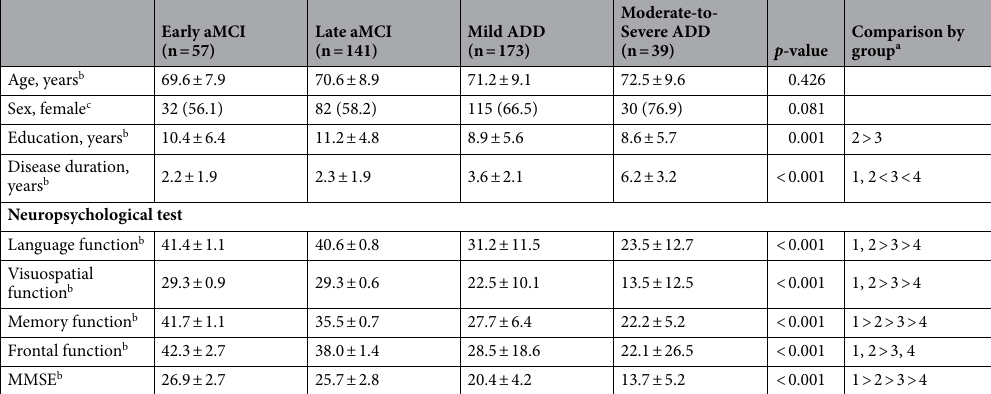
Table 1. Demographic and clinical characteristics of the study population. aMCI amnestic mild cognitive impairment, ADD Alzheimer’s disease dementia, MMSE Mini-Mental State Examination. a 1, Early aMCI; 2, Late aMCI; 3, Mild ADD; 4, Moderate-to-severe ADD. b Continuous variables are expressed as mean ± standard deviation. c Dichotomous variables are expressed as number (relative